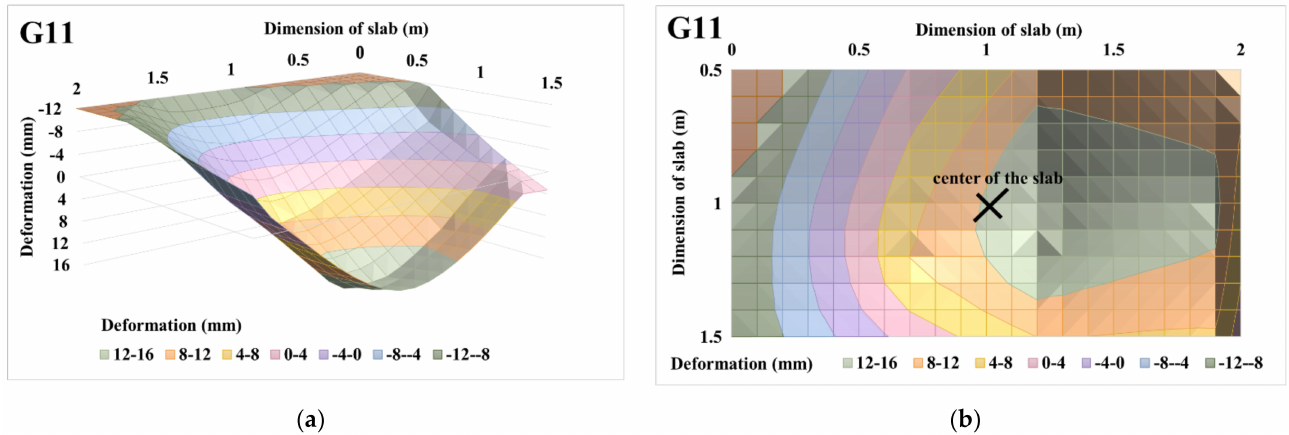
Figure 22. Eccentrically loaded slab G11, with 450 kN load: ( a ) 3D deformation surface of the slab; ( b ) projection of 3D deformation surface of the